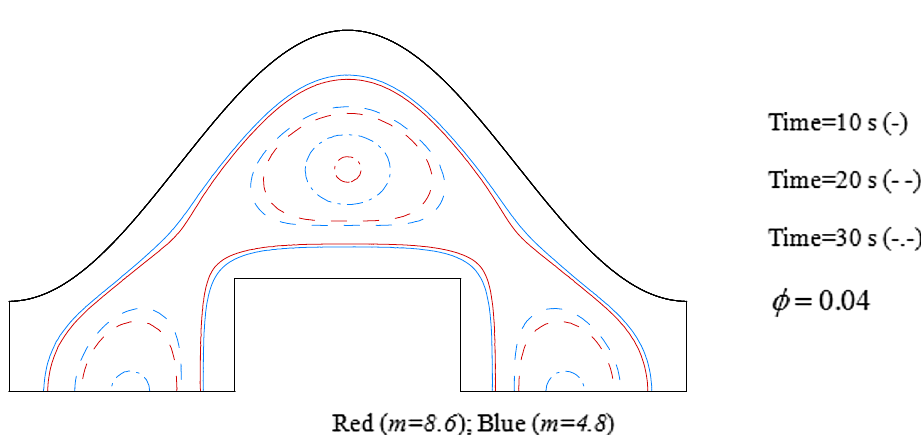
Figure 8. Role of m on movement of ice